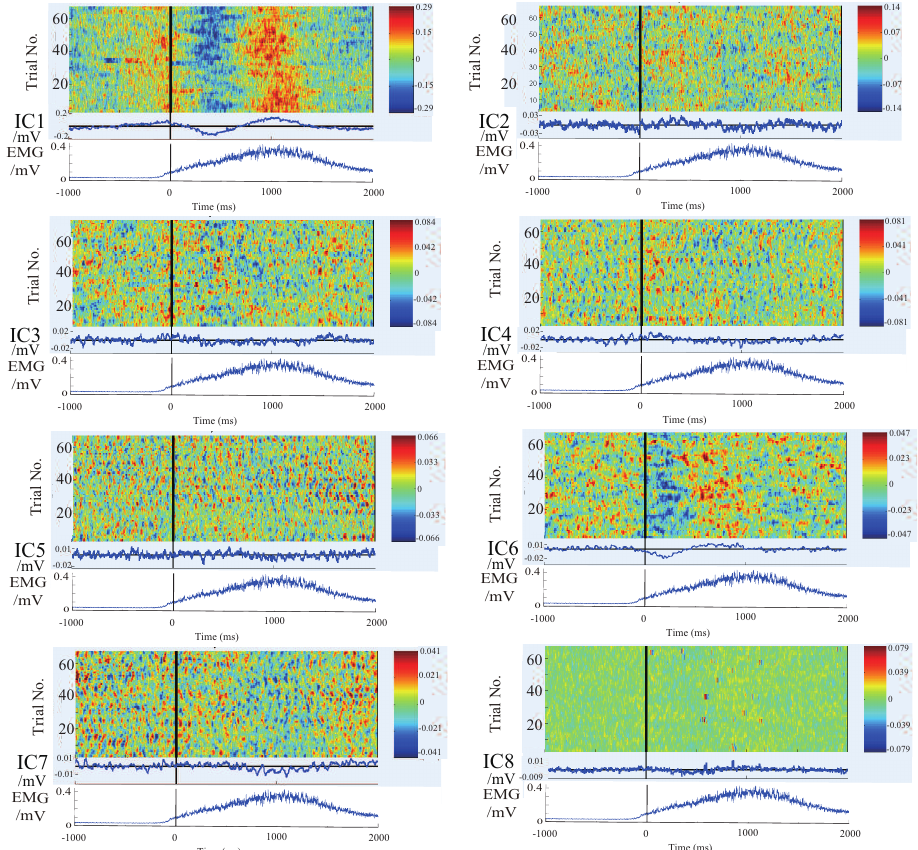
Figure 4. The waveform of each independent component in each experiment of subject A. 8 subpanels in the figure correspond to 8 independent components (IC1–IC8). The upper part of each subpanel shows the amplitude of the independent component restored to all trials at time series, which is plotted by color. The horizontal axis is time, and the black vertical line divides the 3-s data to 1 s before the motion and 2 s after the motion. The vertical axis is the number of trials. The IC part is an average value of EEG signals of all the waveforms produced by all the trials. The lower part is an average value of EMG signal of all the